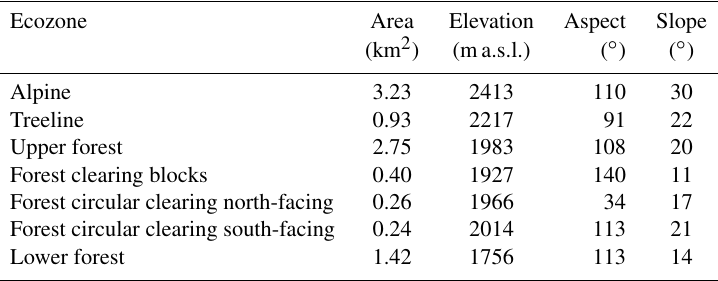
Figure 2. HRU map and ecozones of Marmot Creek Research Basin. Note that the sizes and areas of circular clearings in Twin Creek are not to scale. Table 1. Area and mean elevation, aspect, and slope for ecozones at the Marmot Creek Research Basin. Note that the aspect is in degree clockwise from